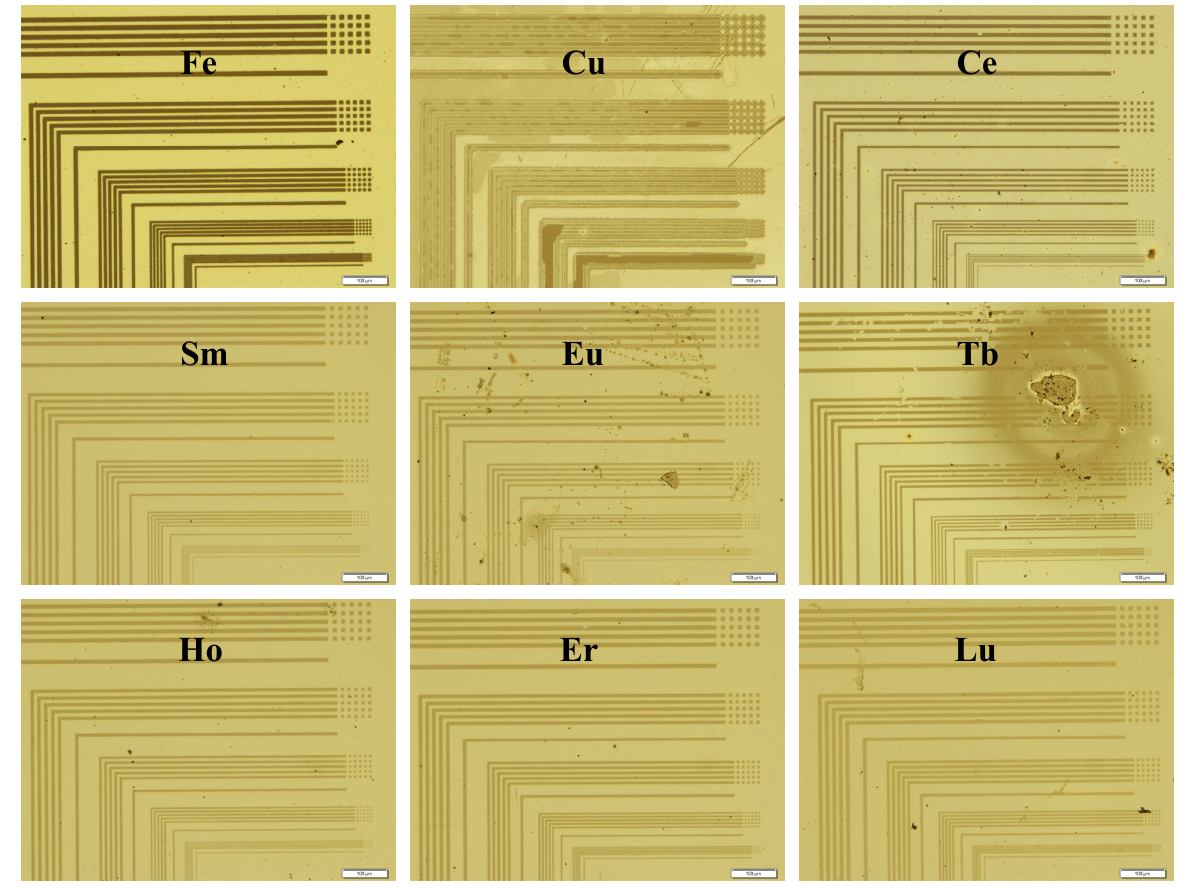
Figure 6. Microscope images of the 2, 4, 6, 8 and 10 μ m trench and hole patterned 1 + metal films on Pyrex substrates after pyrolysis at 500